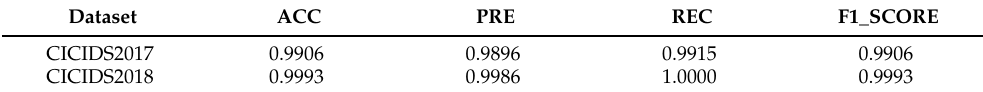
Table 11. Performce of best model generated.